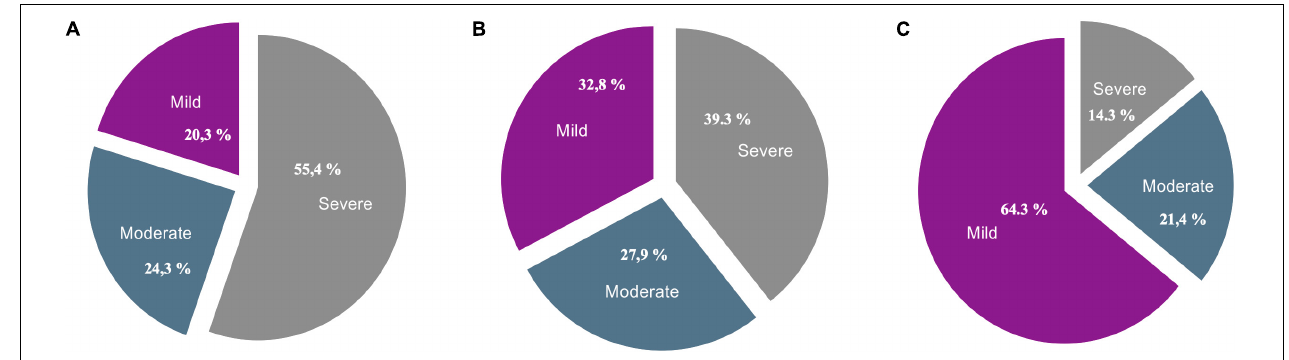
FIGURE 3 | Frequencies [absolute ( n ) and relative (%)] of severity levels of phosphorus (A) potassium (B) and magnesium (C) disorders, within the children with probable Refeeding Syndrome. (A) Total ( n = 74), Mild ( n = 15), Moderate ( n = 18), Severe ( n = 41). (B) Total ( n = 61), Mild ( n = 20), Moderate ( n = 17), Severe ( n = 24). (C) Total ( n = 14), Mild ( n = 9), Moderate ( n = 3), Severe ( n = 2).